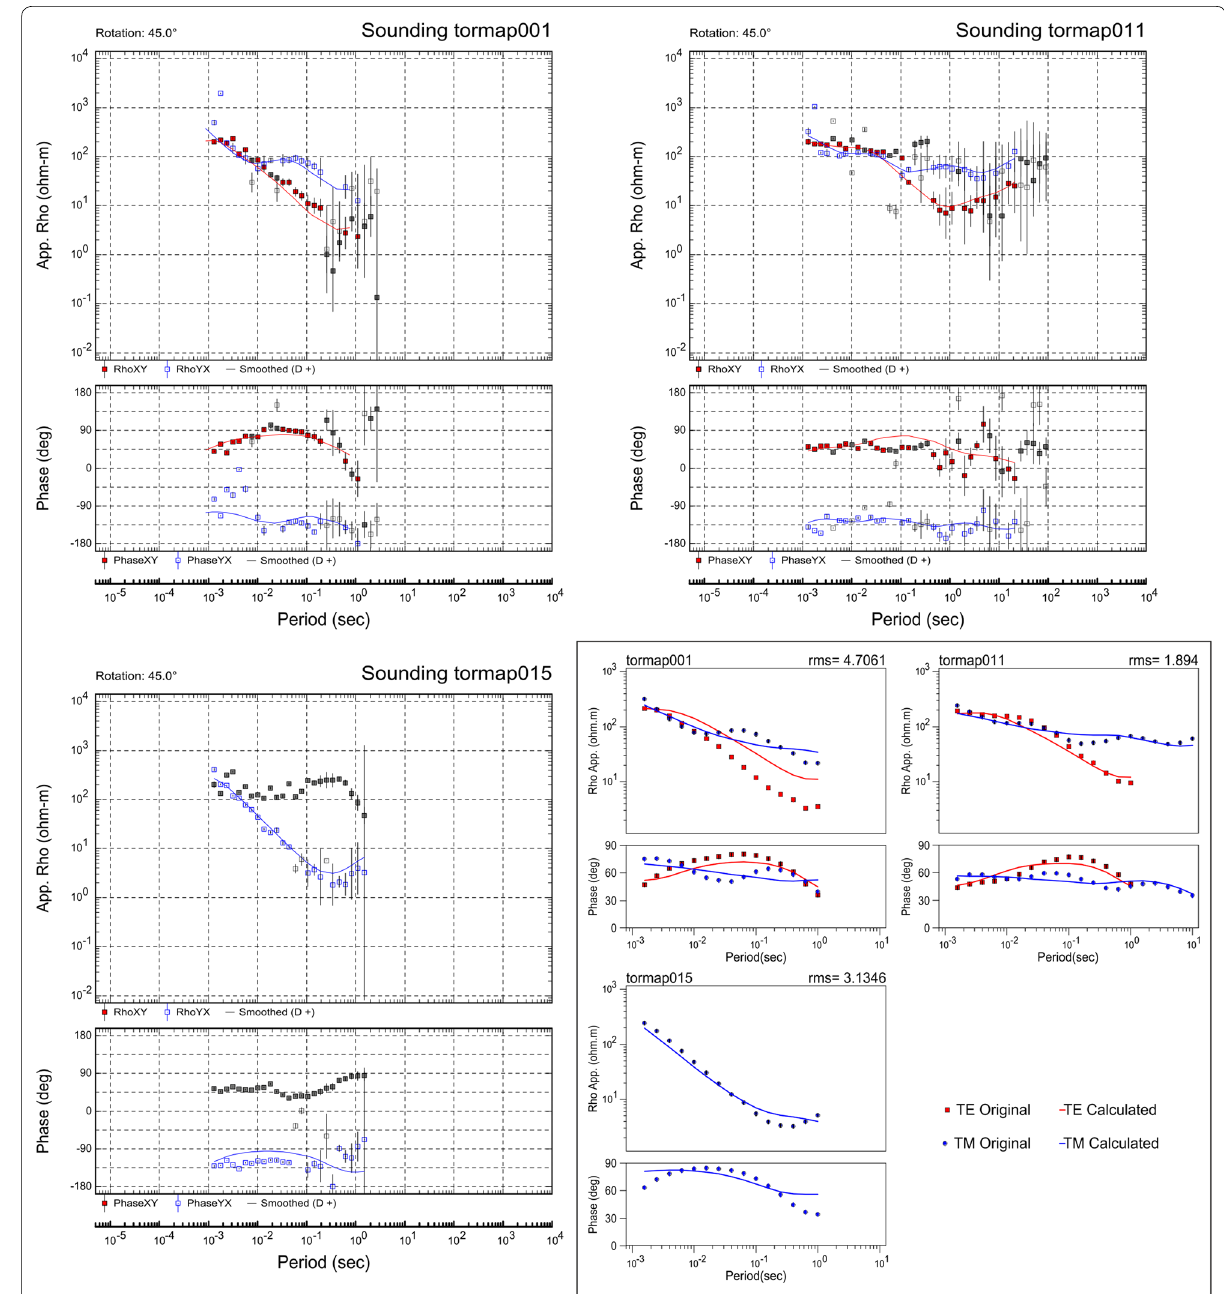
Fig. 8 Apparent resistivity and phases of the original data rotated by 45° (symbols) and smoothed curves after applying D 1, 11 and 15. Red and blue symbols were the ones used to apply the smoothing. Gray symbols correspond to frequencies that were deactivated. Inbox: TE and TM smoothed apparent resistivities and phases and 2D model responses for sites 1, 11 and